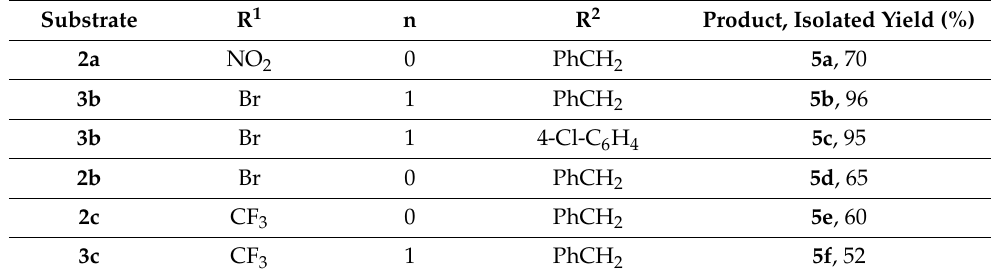
Table 1. Reactions of 2-methyl-3-nitropyridines with thiols. Substrate